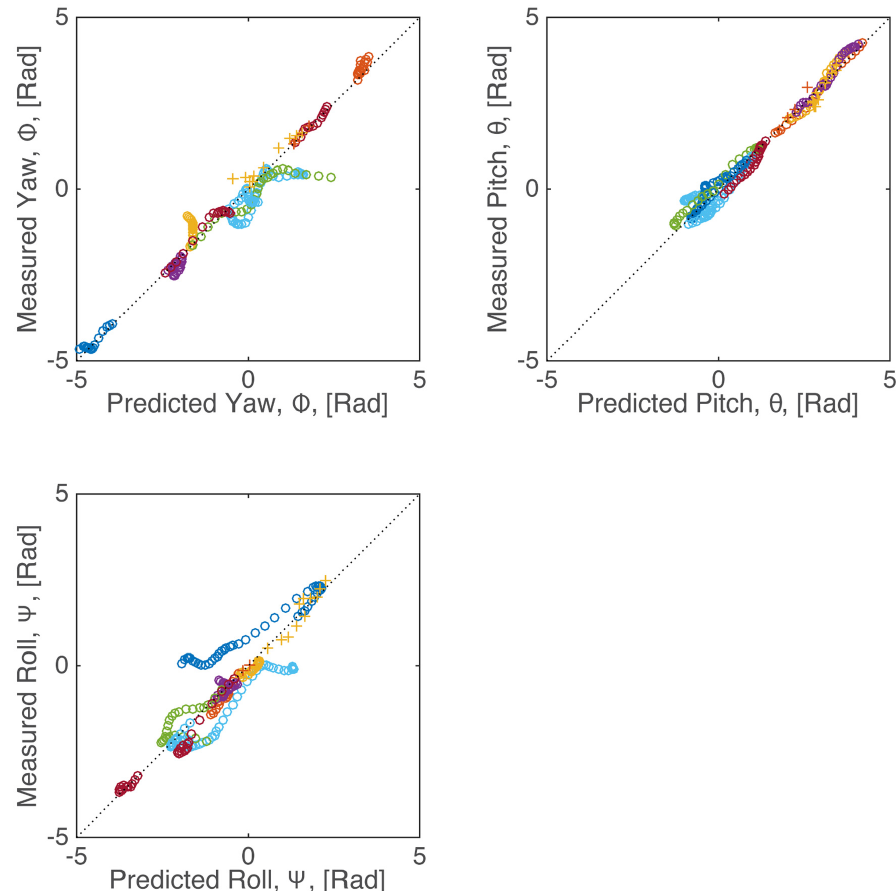
Fig 7. Comparison between the simulated and measured Euler angles for 11 flight sequences. The symbols denote the species ( (cid:7) : C . perspicillata ; +: C . brachyotis ); the colors identify each flight sequence. For clarity, every fifth data point during each flight sequence is plotted. For all flights, after subtracting the angle at t = 0 so as to remove bias, the correlations between the measured and predicted roll, pitch, and yaw angles is R 2 = 0.687, 0.935, and 0.721, respectively. Data available in file EulerAngles.txt from the Dryad Digital Repository, http://dx.doi.org/10.5061/dryad.21qs5